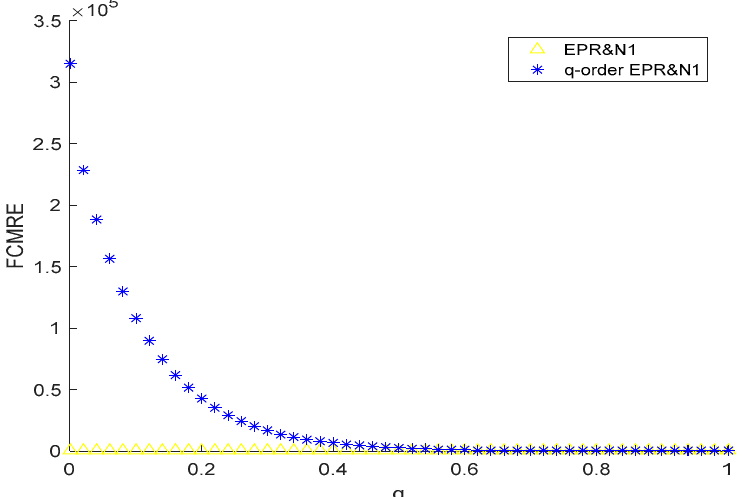
Figure 6. The fractional cumulative residual MRE of EPR, N1 time series, and q-order of fractional cumulative residual MRE.